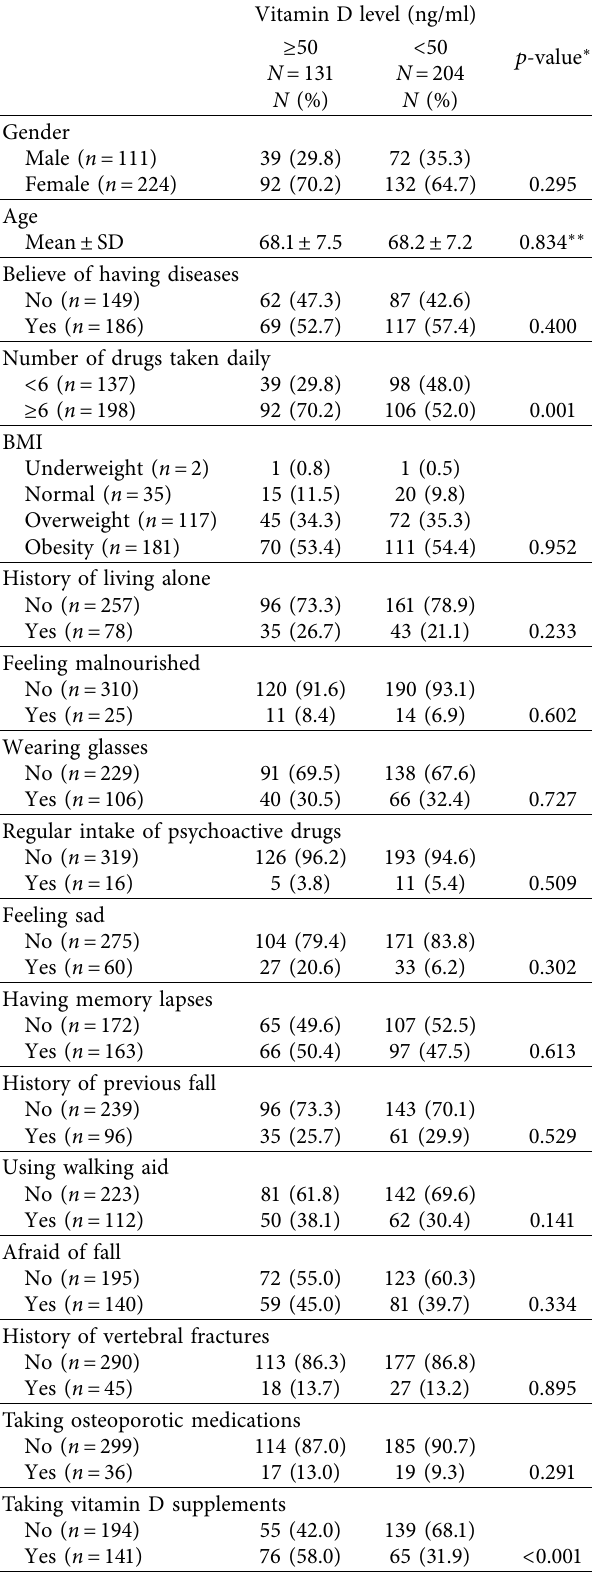
Table 1: Factors associated with vitamin D levels among elderly people,